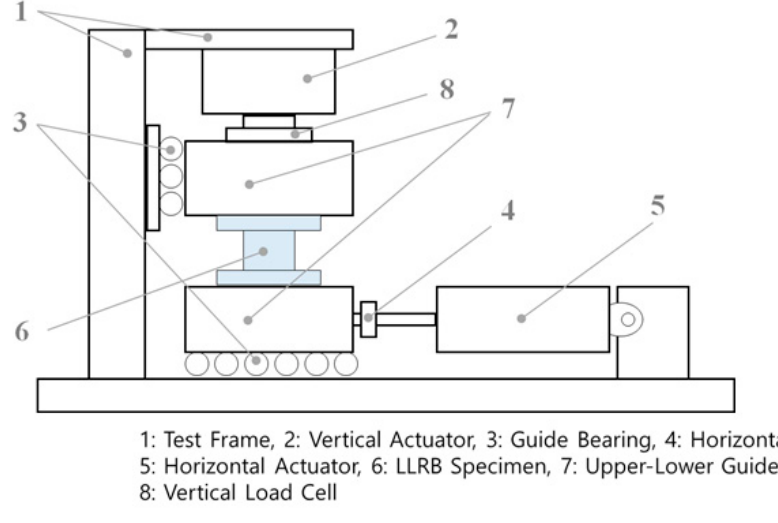
Figure 9. Schematics of quasi-static test facility.